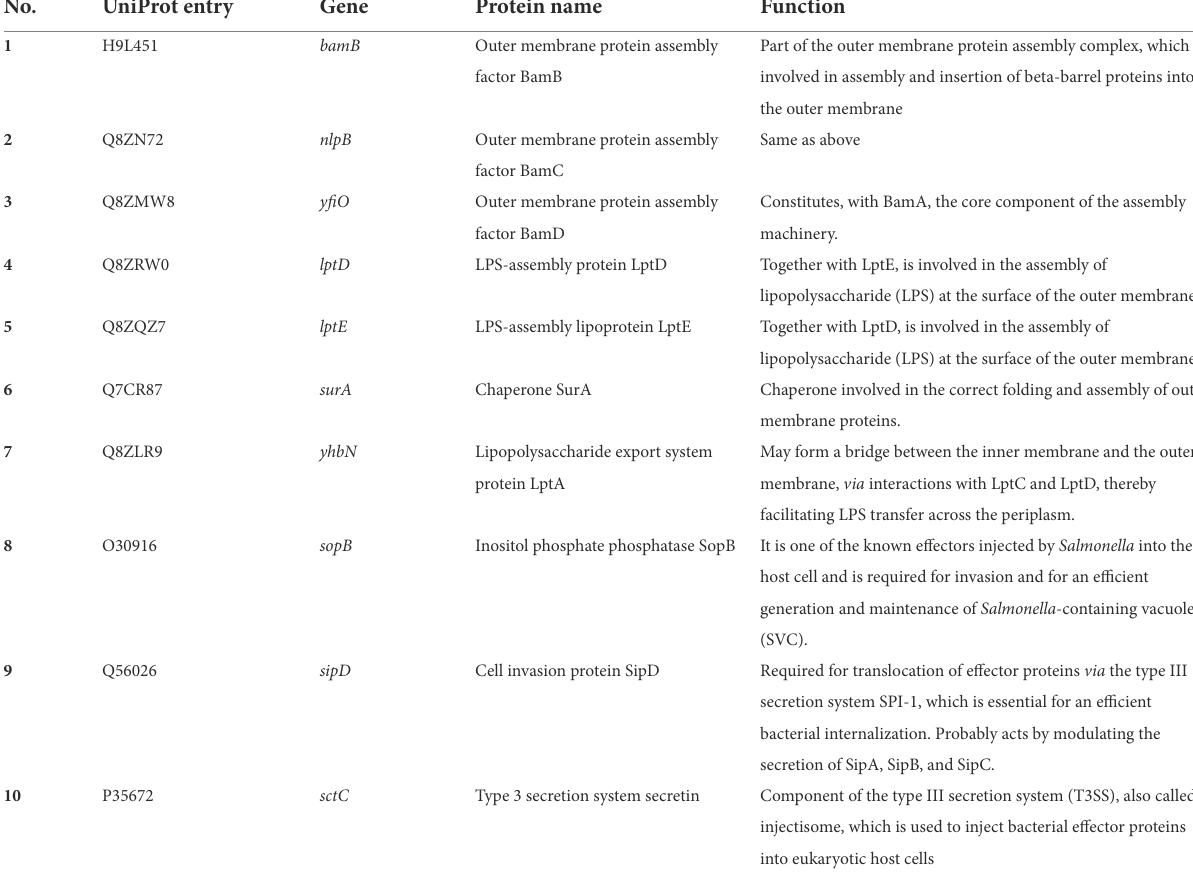
TABLE 2 Summary of 10 notable proteins identified in extracellular vesicles, including outer membrane structural proteins and Salmonella effector proteins.